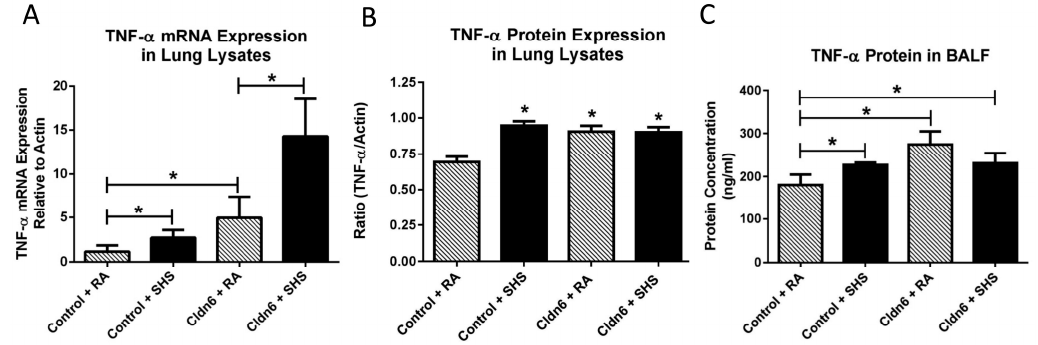
Figure 6. TNF- α mRNA ( A ) and protein ( B ) were assayed in whole lung lysates by qPCR and immunoblotting, respectively. SHS increased TNF- α transcription in both control and Cldn6 TG animals. TNF- α protein in lung lysates was significantly increased in SHS-exposed controls, but no increase was observed in Cldn6 TG mice following SHS exposure; ( C ) ELISAs were used to detect secreted TNF- α in BALF. Secreted TNF- α was increased in control mice following SHS exposure. Despite a slightly higher basal level of secretion by Cldn6 TG mice, SHS did not significantly increase TNF- α secretion. Data are representative of experiments involving six mouse lung samples per group and * p ≤ 0.05.